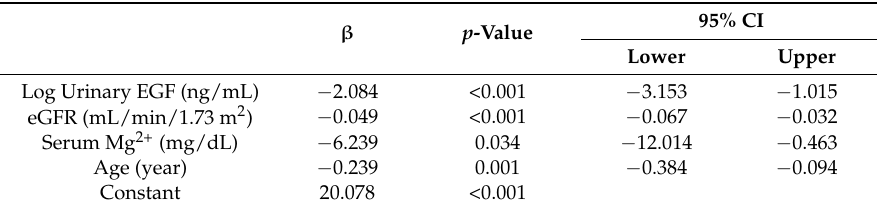
Table 4. log EGF as a predictor of FE Mg 2+ . Table 4. Log EGF as a predictor of FE Mg 2+